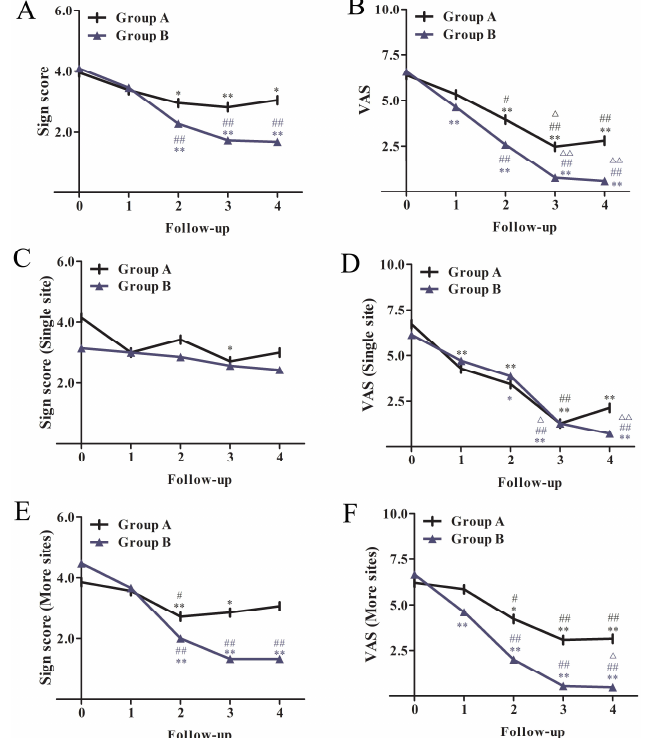
Figure 2. Sign score and VAS trends before and after treatment and during follow-up in each group. ( A , C , E ) Sign score of all patients ( A ), patients with a single site of mucosal involvement ( C ), patients with more than one site of mucosal involvement ( E ) in Group A and B, ( B , D , F ) VAS of all patients ( B ), patients with a single site of mucosal involvement ( D ), patients with more than one site of mucosal involvement ( F ) in Group A and B. * Compared with baseline, * p < 0.05, ** p < 0.01, # compared with the 1st follow-up, # p < 0.05, ## p < 0.01, △ compared with the 2nd follow-up, △ p < 0.05, △△ p < 0.01 .